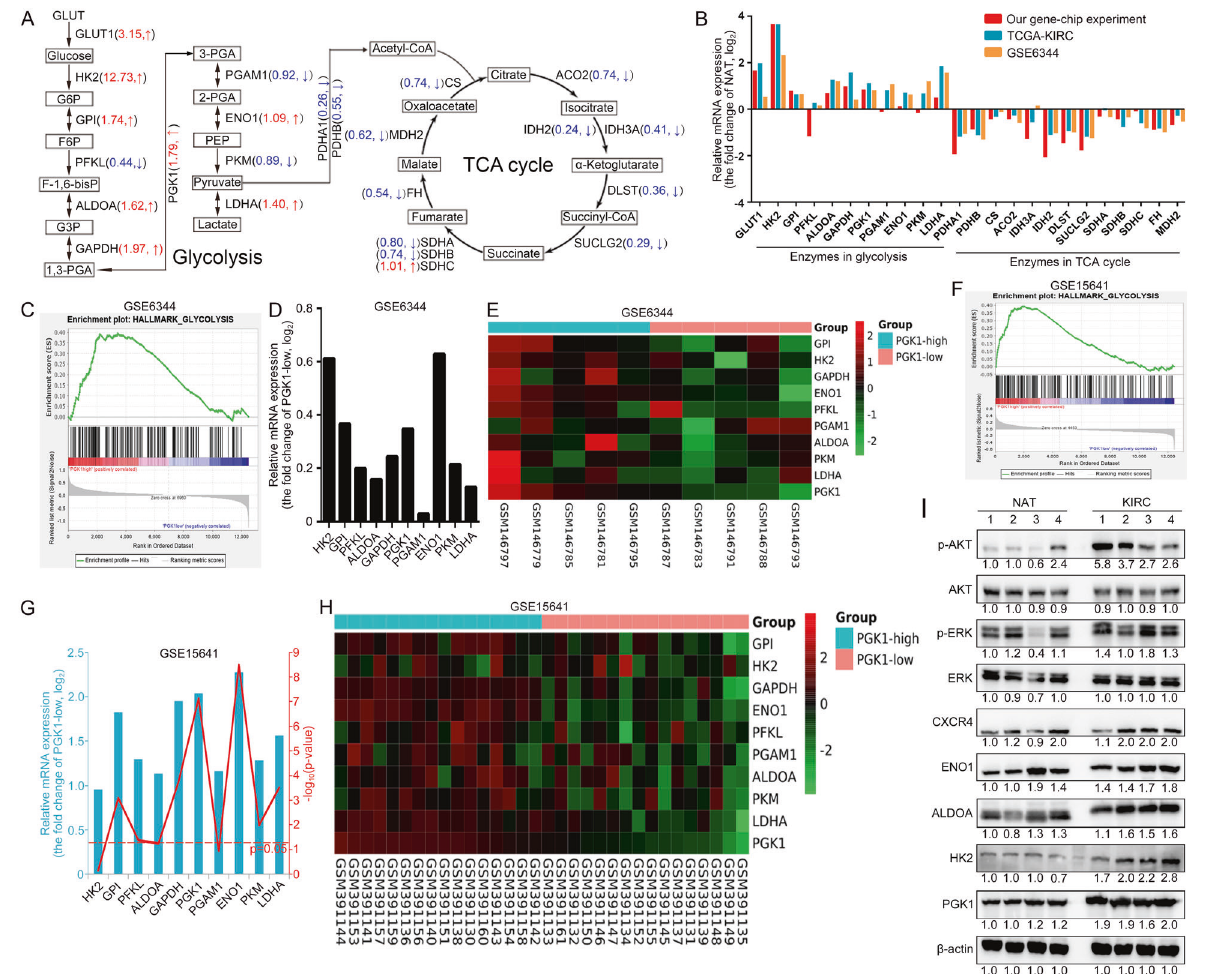
Fig. 7 PGK1 is positively correlated with key glycolysis-related gene expression in KIRC clinical samples. A Schematic representation of differences in the mRNA expression levels of enzymes related to glucose metabolic pathways (glycolysis and TCA cycle) between normal kidney tissues and KIRC tissues. The values indicated the fold change over the normal sample (positive values represented upregulation compared with the normal sample, negative values represented downregulation compared with the normal sample). B Glucose metabolic relative gene expression pro fi ling was summarized from our gene chip results combined with online transcriptome data from GSE6344 and TCGA-KIRC databases. PGK1 expression in KIRC was positively correlated with glycolysis process ( C ) including several glycolysis-related enzymes ( D ) according to GSE6344 dataset analysis. E Heat map of the glycolysis-related DEGs from high abundance of PGK1 group ( N = 5) and low abundance of PGK1 group ( N = 5) from GSE6344 dataset analysis. F , G GSE15641 dataset with the largest sample size demonstrated PGK1 upregulation was often accompanied by high expression of other glycolysis-related enzymes. H Heat map of the glycolysis-related DEGs from high abundance of PGK1 group ( N = 16) and low abundance of PGK1 group ( N = 16) from GSE15641 dataset analysis. I The